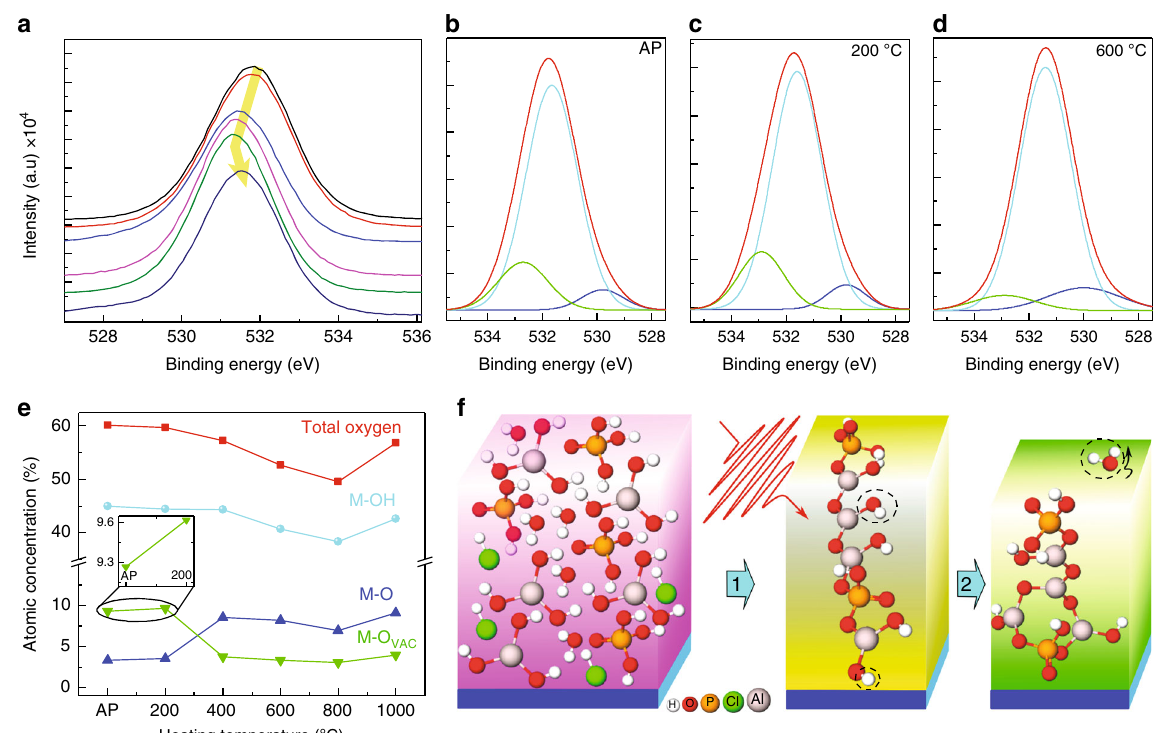
Fig. 4 Temperature dependent changes in trap states. a Core level O 1s spectra from different temperature heated fi lm. Thick arrow indicate movement of the peaks obtained from samples heated with different temperatures. b – d Core level oxygen peaks from as-prepared, 200 and 400 °C heated ALPO fi lms, respectively. The oxygen peak (red) in each case is de-convoluted into three components corresponding to oxygen vacancies (M-O vac ) is green, lattice oxygen (M-O) is blue, and metal hydroxide (M-OH) is cyan. e Atomic composition ratios of oxygen in ALPO thin fi lms as a function of temperature. (inset) increment of traps O VAC at 200 °C with respect to AP ALPO fi lm. f Schematics showing condensation mechanism of oxide precursors by heating. The fi rst block denotes the individual molecules, second and third are low and high temperature processed ALPO fi lms, respectively. All molecular models